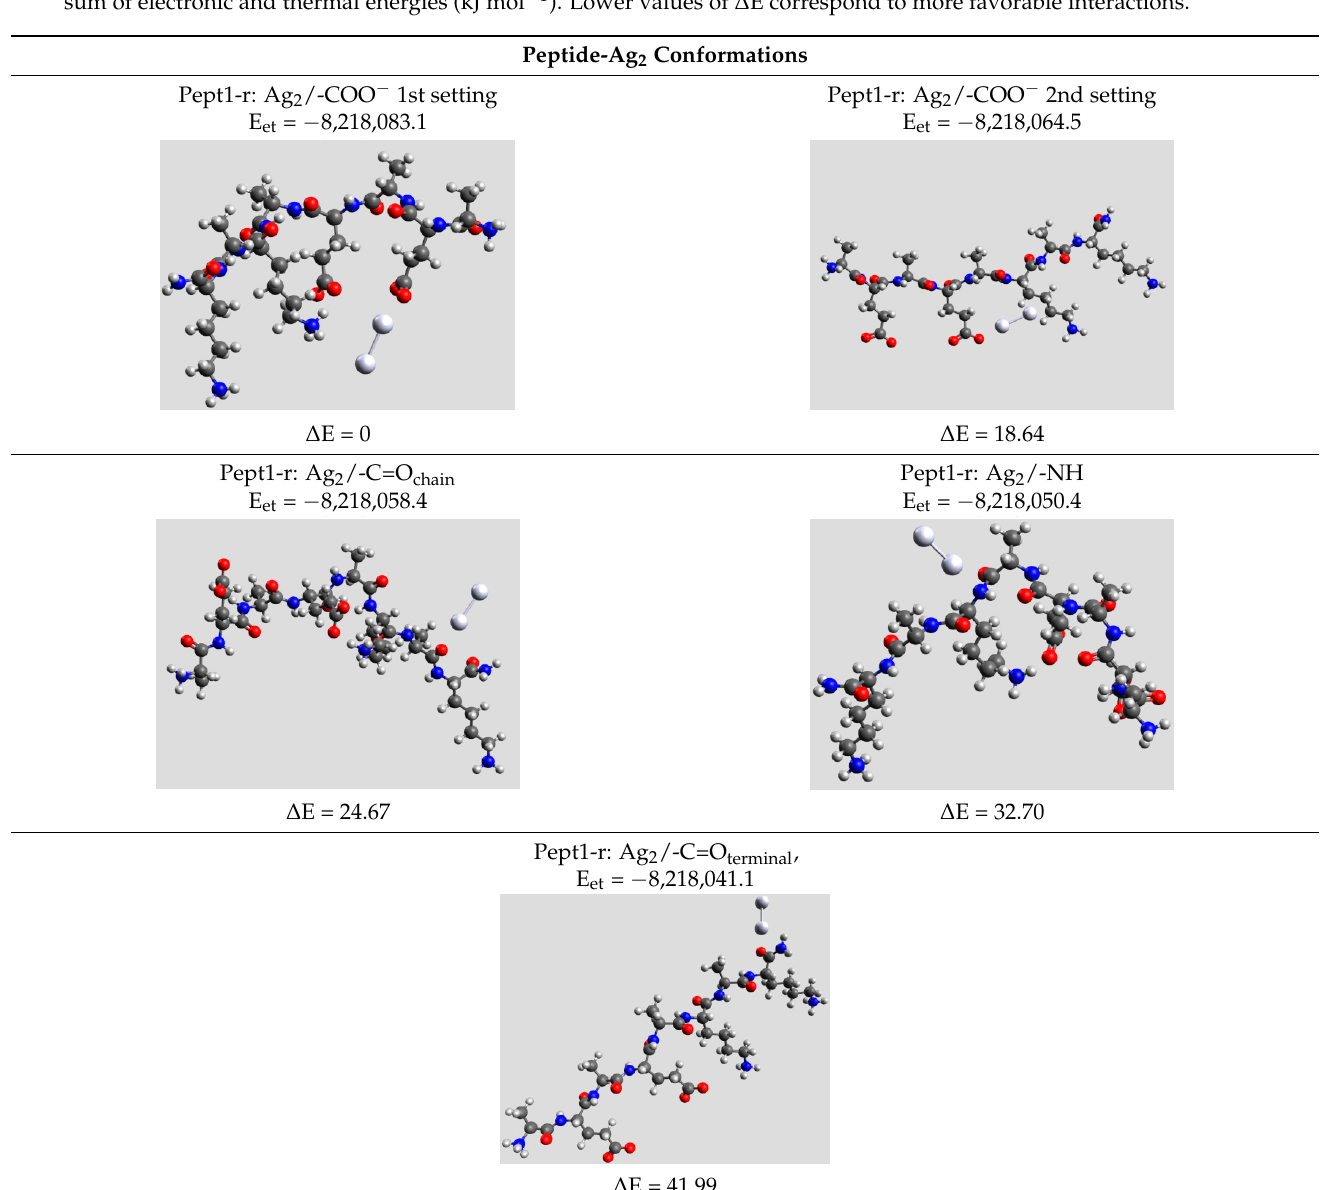
Regarding the peptide bonds, their SERS bands’ intensities (particularly Amide I)